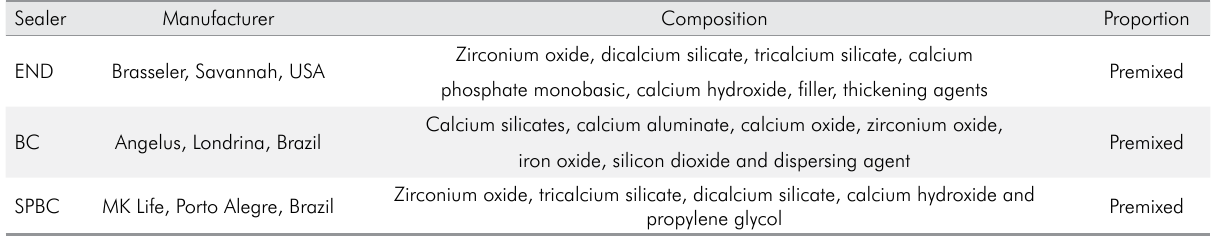
Table 1. The calcium silicate-based sealer, manufacturers, compositions and proportions used.